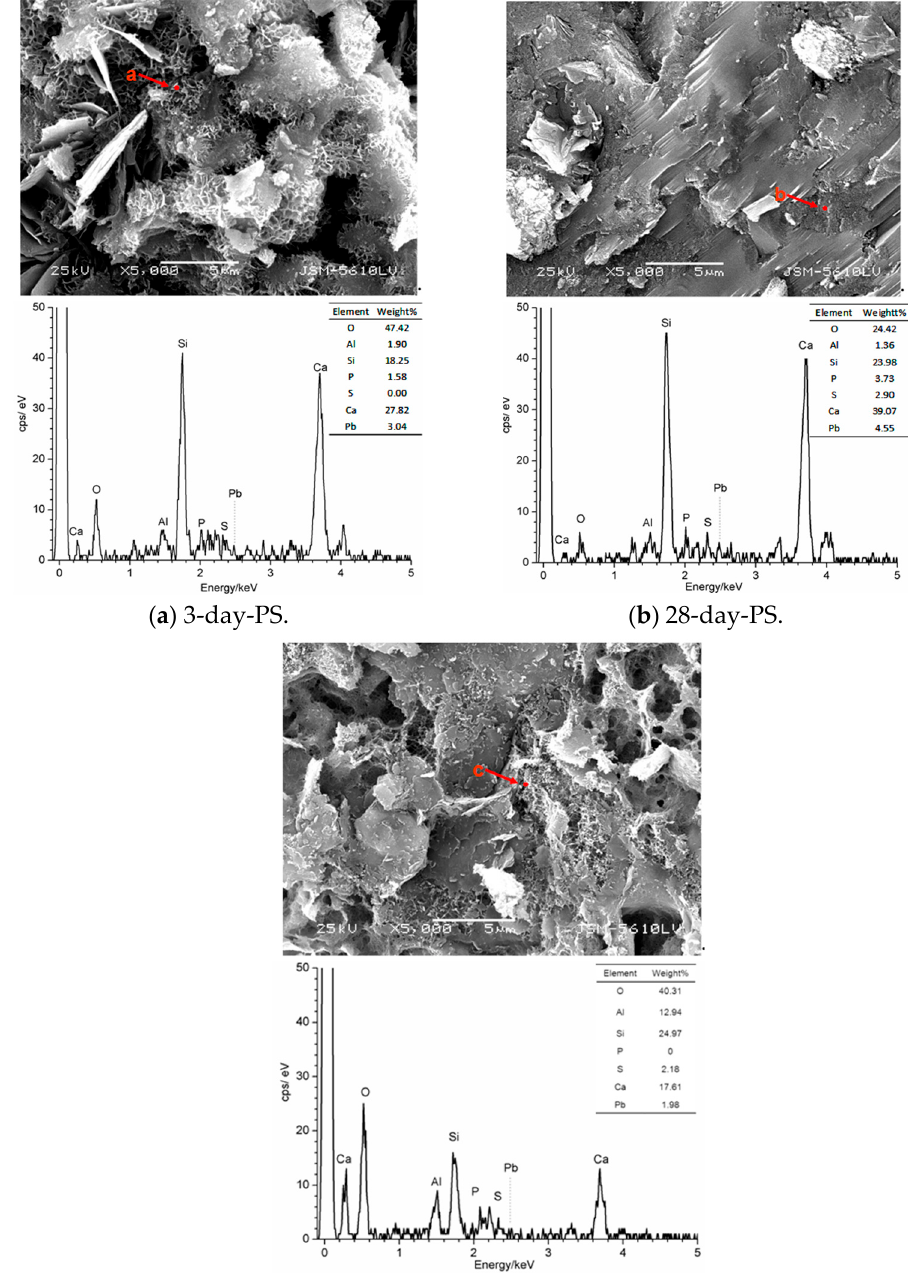
Figure 6. EDS-SEM micrographs of leaded solidified samples at different hydration ages. ( a ) 3-day-PS, ( b ) 28-day-PS, ( c ) 28-day-PC.